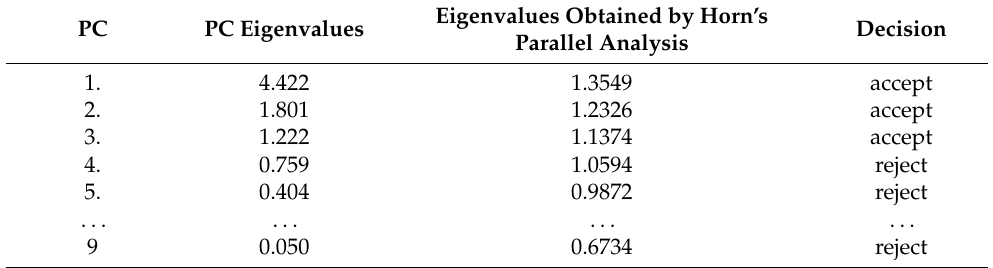
Table 3. Results of Horn’s parallel analysis.